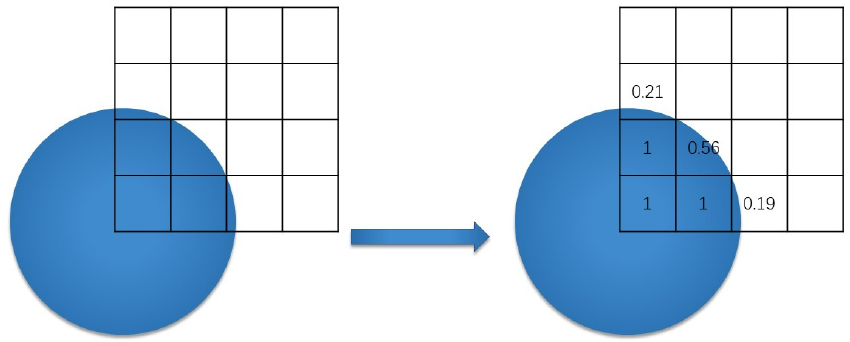
Figure 4. Principle of Eulerian Analysis.